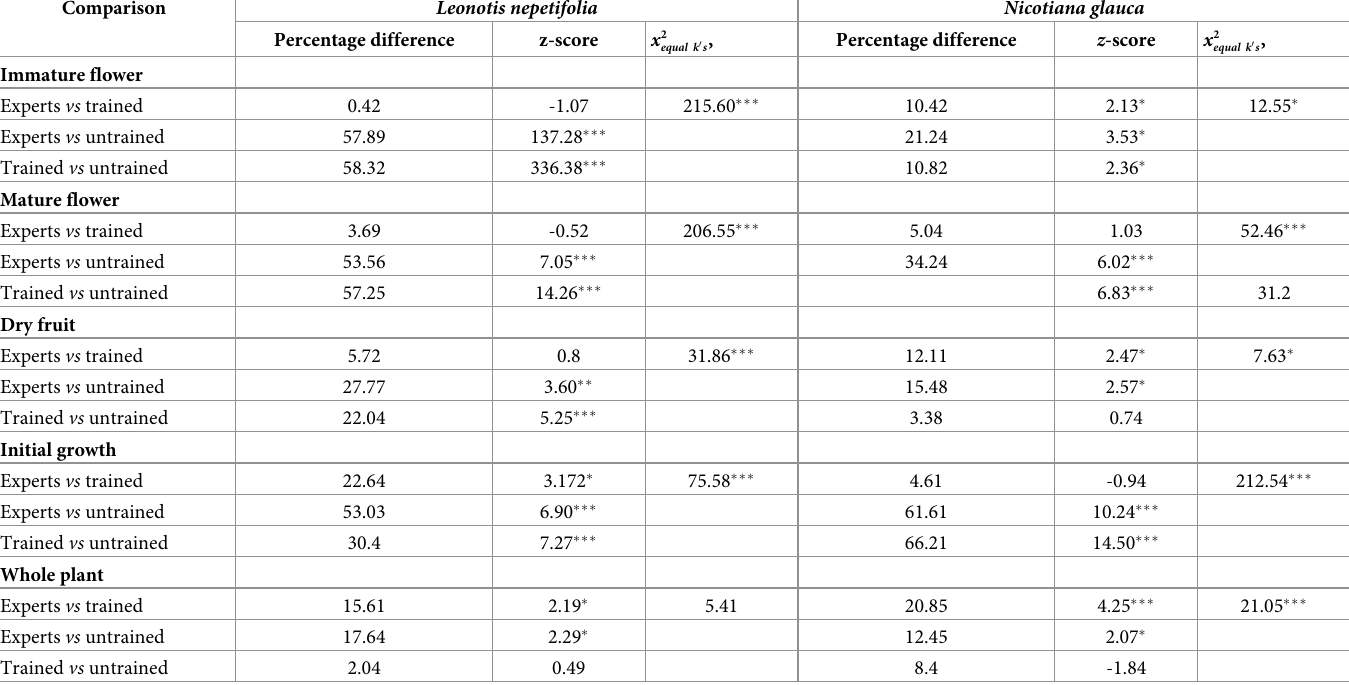
Table 1. Comparisons and degree of agreement between raters (3 groups) phenophases (three reproductive and two vegetative) and two species ( L . nepetifolia and N . glauca